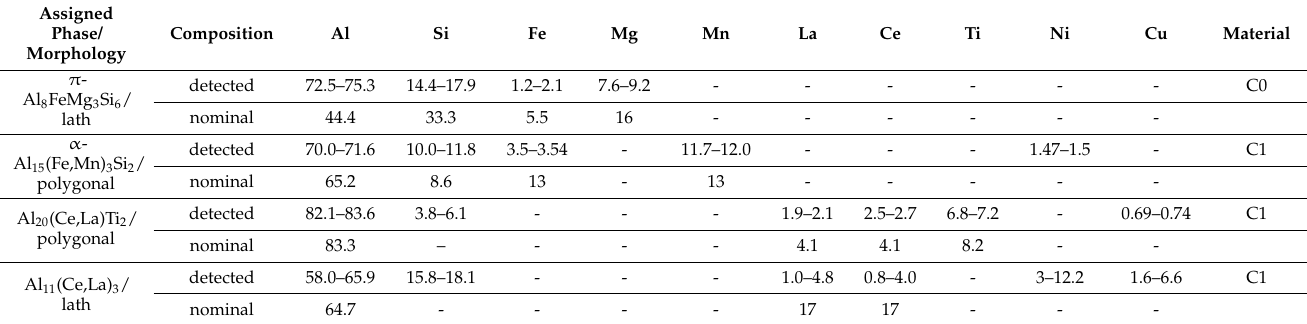
Table 2. Chemical composition range [at.%] of intermetallic phases from EDS spectra.